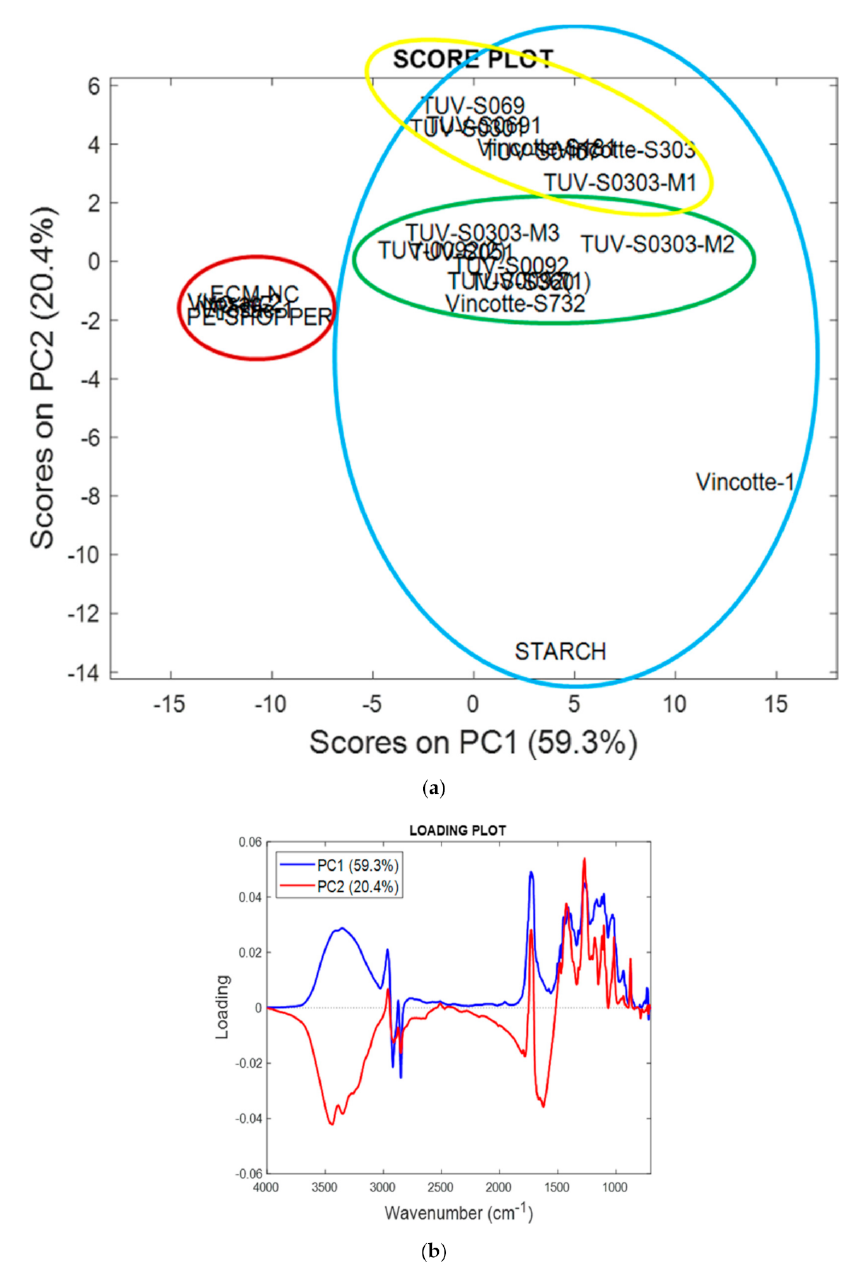
Figure 6. PCA results as score plot ( a ) and loading plot ( b ) obtained by using R software. The compostable population resulted furtherly separated into two subgroups, in turn separated from the sample named Vinçotte-1 and from starch, on component 2 (PC2), explaining the 20.4% of variance. In particular, a group of compostable samples was detected, including M1 and Vinçotte-S303 (circled in yellow), separated from a group including M2, M3, and Vinçotte-S732 (circled in green). They were differently distant from starch, representing the renewable material. Rationally, M2, M3, and their group,